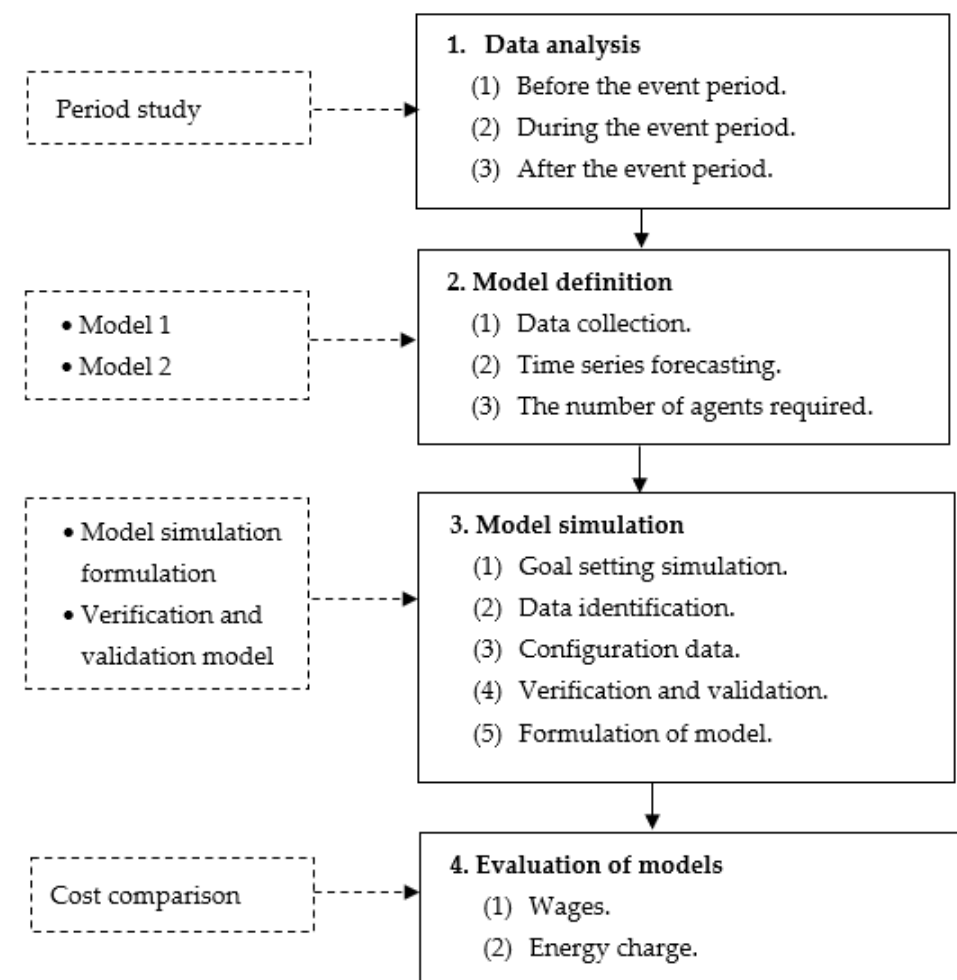
Figure 2. Workforce planning framework in a call center.